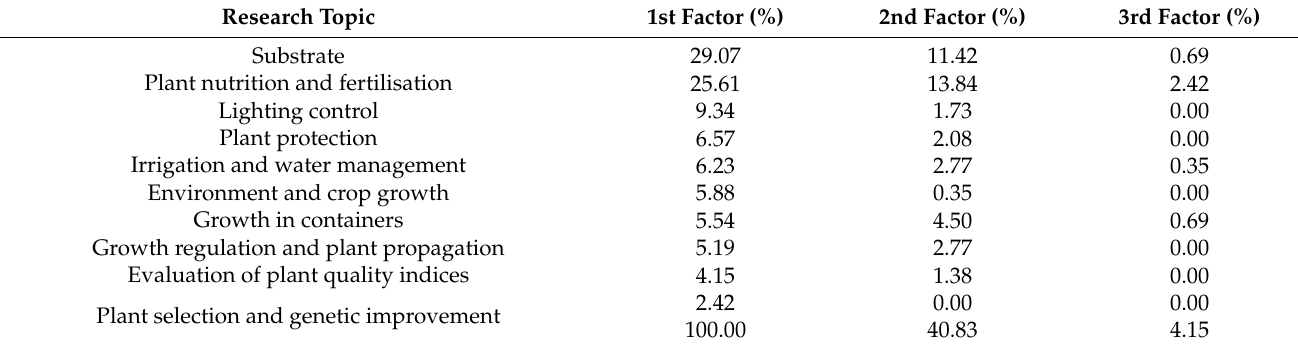
Table 1. Main research topics identified in the set of publications analysed in this study ( n = 289). Research Topic